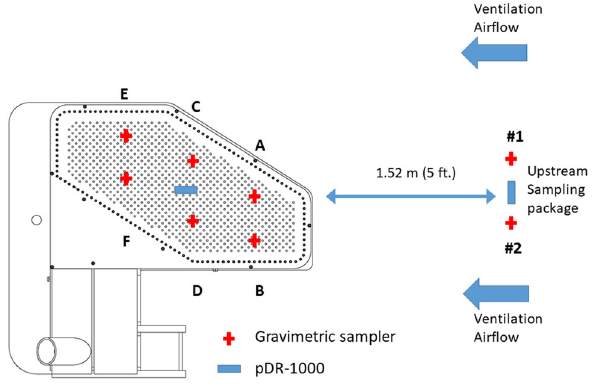
Fig. 4 Gravimetric filter and pDR locations below the CAC (sam- pling locations are approximate), including upstream sampling location. Large blue arrows depict ventilation